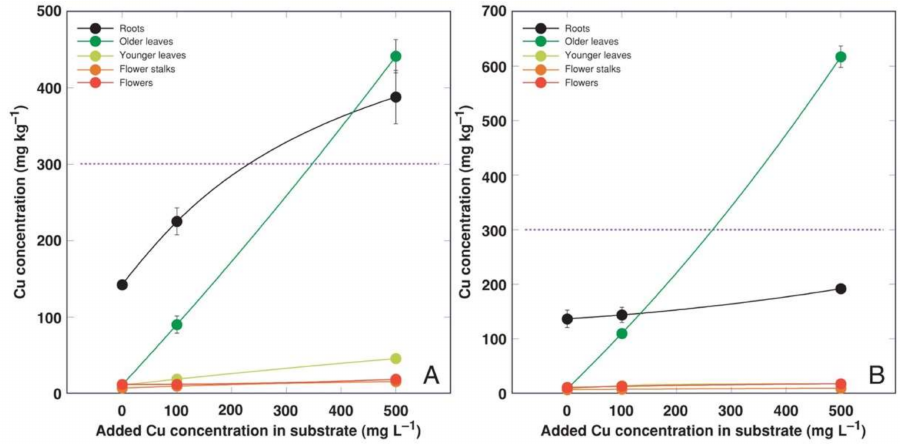
Figure 5. Effect of added Cu concentration in soil on Cu concentration in different parts of Armeria maritima plants of accession AM1 ( A ) and AM2 ( B ) after cultivation for 9 weeks. Data are means ± SE from 3 samples. Dotted line indicates accepted hyperaccumulation threshold level for the respective